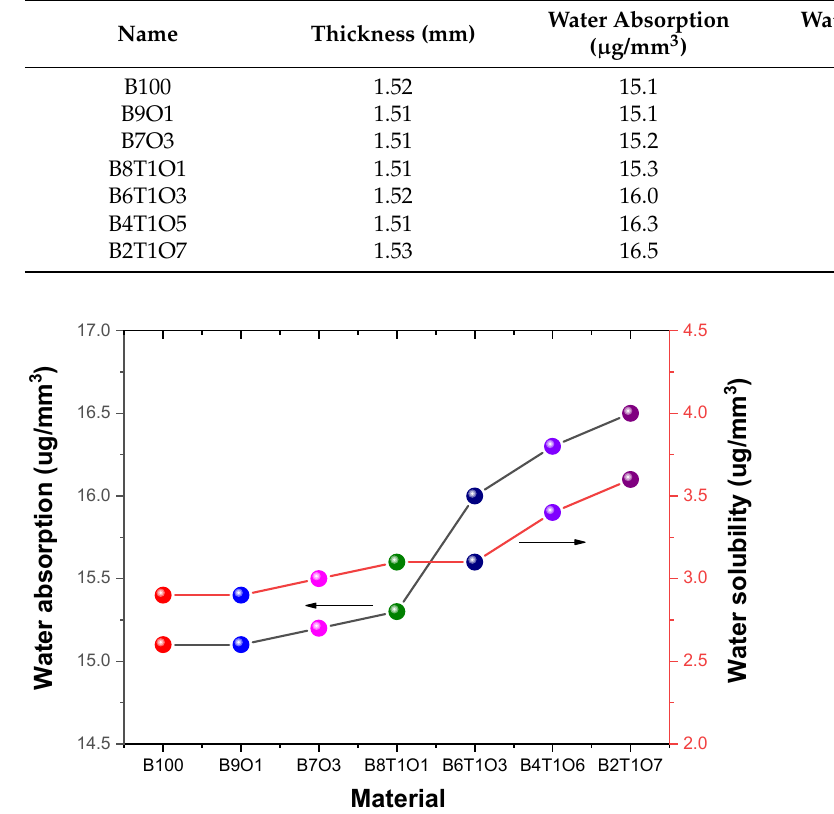
Figure 8. Water absorption and water solubility of the 3D-printed specimens.